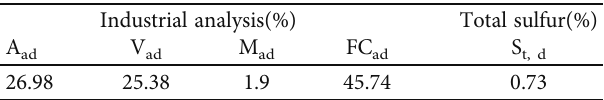
Table 1: Industrial analysis and total sulfur content analysis of SP